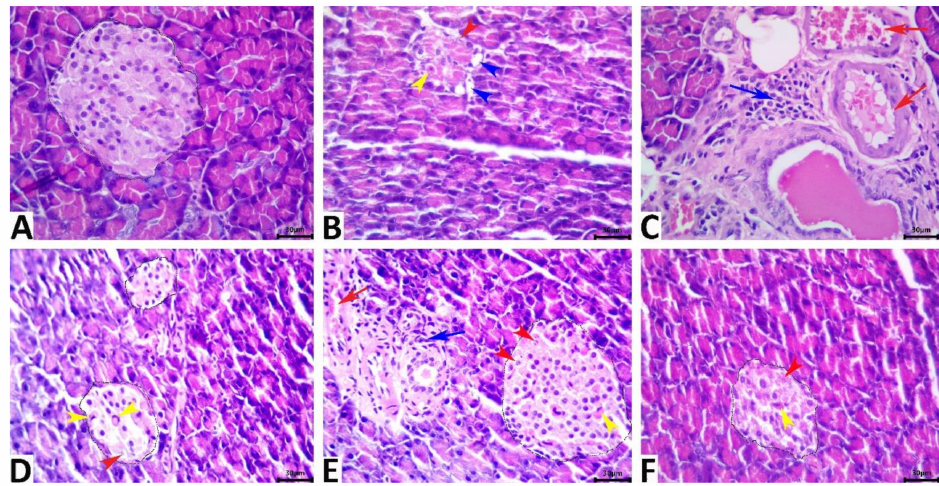
Figure 7. Representative photomicrograph of the hematoxylin and eosin-stained pancreatic tis- sue sections showing normal histology of the exocrine and endocrine tissues in the vehicle con- trol rat ( A ). The STZ-diabetic pancreas shows a diminished islet of the Langerhans size with β cell vacuolations (blue arrowheads), apoptosis (yellow arrowhead), and necrosis (red arrowhead) ( B ), and periductal mononuclear cell infiltration (blue arrow) with vascular congestion (red arrow) ( C ). The pancreas of the STZ-3MA-treated animal shows β cell apoptosis (red arrowhead), and necrosis (yellow arrowhead) ( D ). The pancreas of the STZ-LPs-CUR-treated animal shows vascular congestion (red arrow), periductal mononuclear cell infiltrate (blue arrow), and β cell apoptosis (yellow arrowhead), pyknosis (blue arrowhead), and chromatorhexis (black arrowhead) ( E ). The pancreas of the STZ-LPs.CUR-3MA-treated animal shows β cell apoptosis (yellow arrowhead), and necrosis (red arrowhead) ( F ). Scale bars = 30